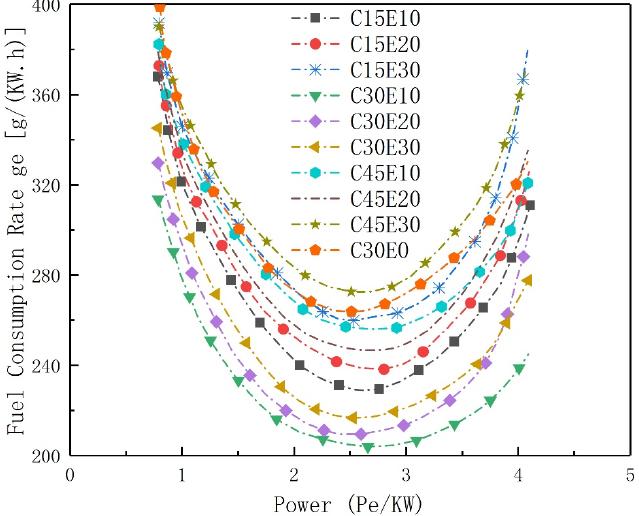
Figure 7. Load characteristics of all swirl chamber diesel engine schemes at the rotation speed of 1200 r/min. Note: the scheme numbers are the same as those in Table 1.